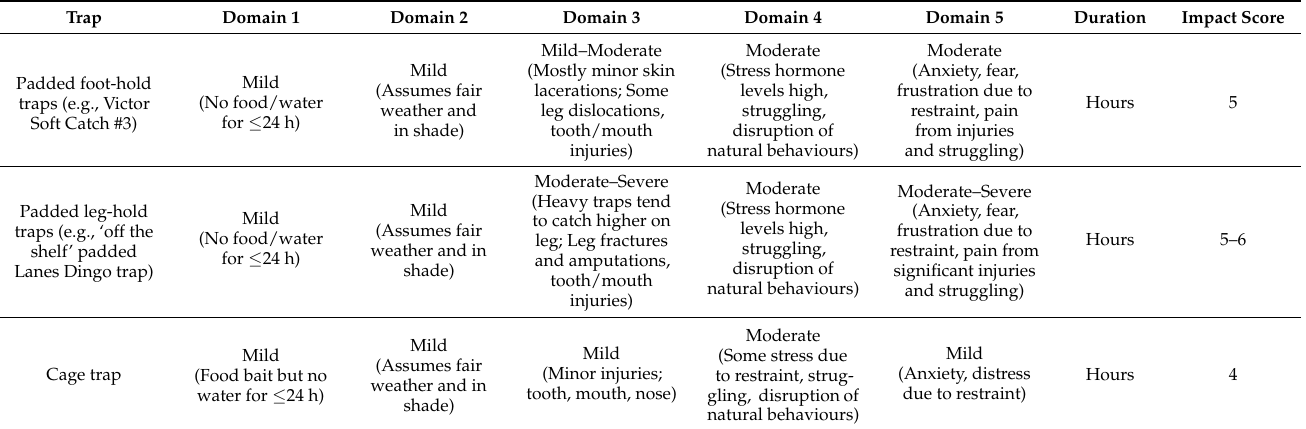
Table 2. Part A assessments of three types of restraining (non-lethal) traps used for wild dogs ( Canis